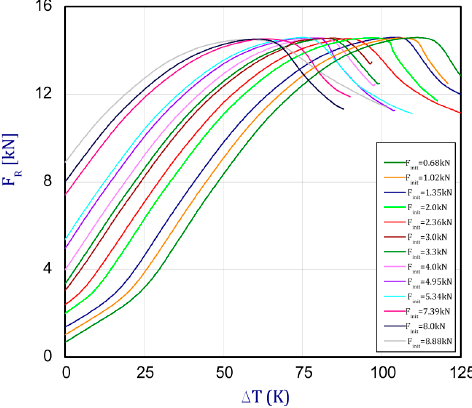
Figure 7. The force reaction vs. the temperature increment for different preloads obtained by FEM. For higher initial loads, the proportional characteristics are seen but only in a limited range.